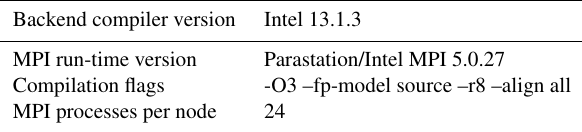
Table 2. System set-up details for the analysis done on the JUDGE system.